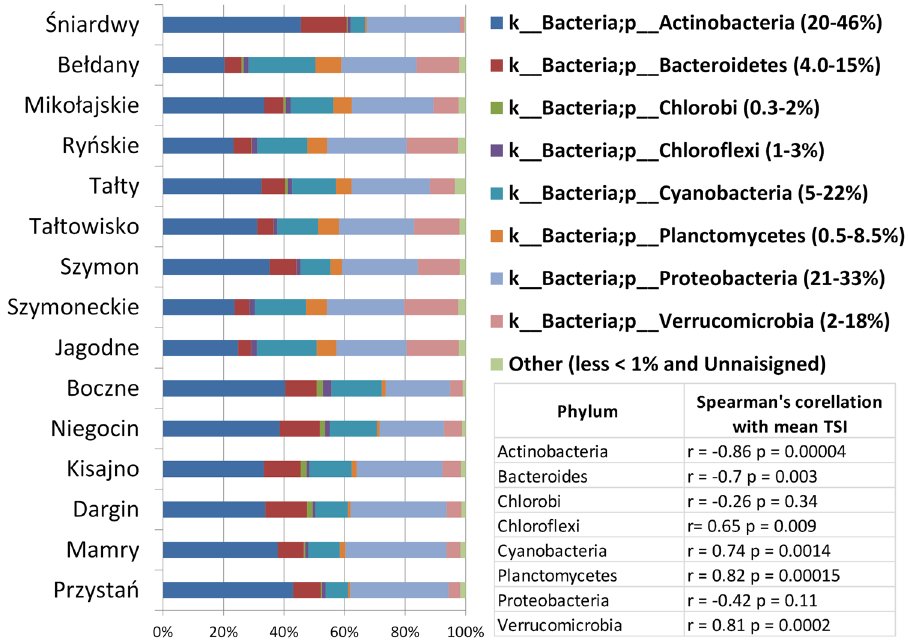
Figure 2. Relative sequence abundance of dominant bacterial phyla associated with different lakes. Only phyla whose relative share exceeded 1% were taken into account as individual units. Spearman correlations between the TSI and microorganisms belonging to the dominant phyla were